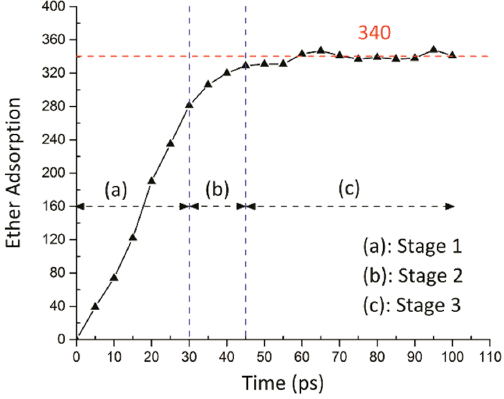
Figure 7. The number of ether molecules adsorbed on single sphere model.